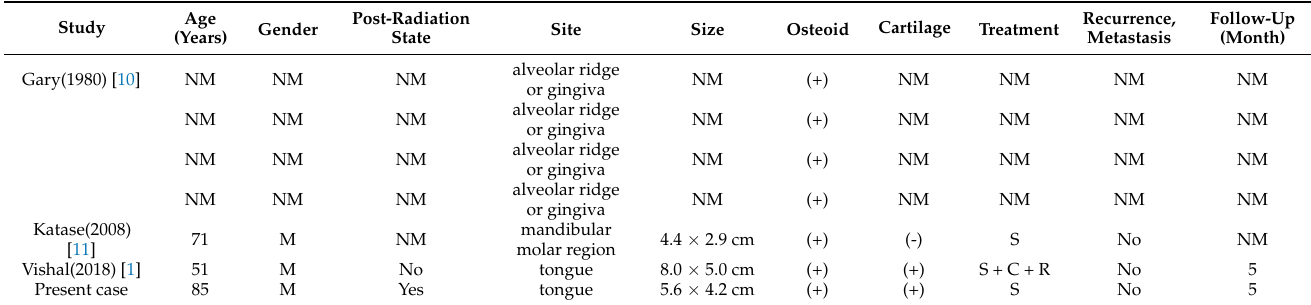
Table 1. Summary of previous and current reports of spindle cell carcinoma (SCSCC) and carcinosarcoma with osteoid and cartilage formation in the oral